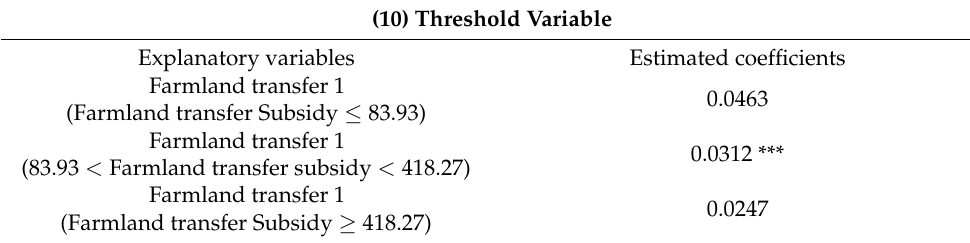
Table 6. Analysis of threshold effect of farmland transfer subsidy.